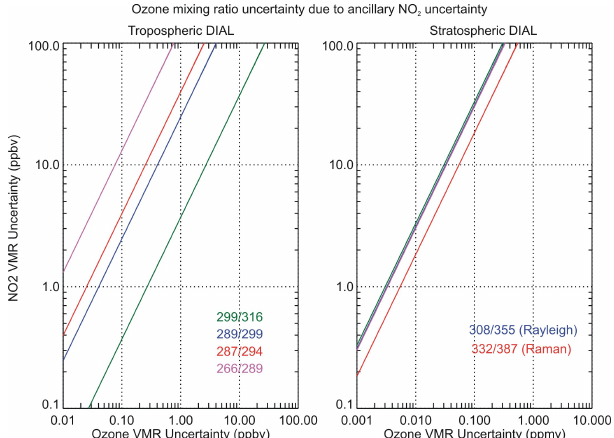
Figure 12. Ozone mixing ratio uncertainty as a function of NO 2 mixing ratio uncertainty (ppbv). Left plot: tropospheric ozone DIAL pairs (uncertainty in ppbv). Right plot: stratospheric ozone DIAL pairs (uncertainty in